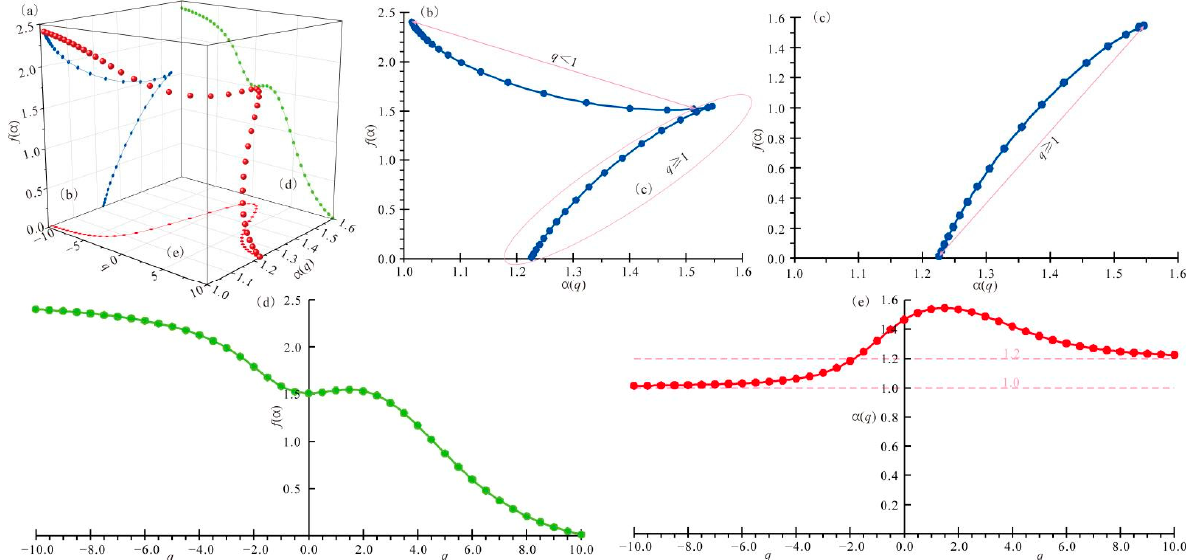
Figure 6. Multi ‐ fractal spectrum of faults in the study area. ( a ) 3 ‐ D plot of q , α ( q ), f ( α ), showing points ( q , α ( q ), f ( α )) in the three ‐ dimensional coordinate system is a spiral; ( b ) 2 ‐ D plot of α ( q ), f ( α ), showing the curve connected by points ( α ( q ), f ( α )) is not a common parabolic (or hook) shape with downward opening, but a combination of two semi ‐ parabolic shapes with opposite opening directions; ( c ) When the q ‐ order moment ranges from 1 to 10, the curve connecting the points ( α ( q ), f ( α )) is a typical semi ‐ parabolic shape; ( d ) f( α ) ranges from 0.0120 to 2.4020, and decreases as a whole and increases locally with the increase of the order moment q ; and ( e ) the singularity index α ( q ) first increases and then decreases with the increase of the order moment q .